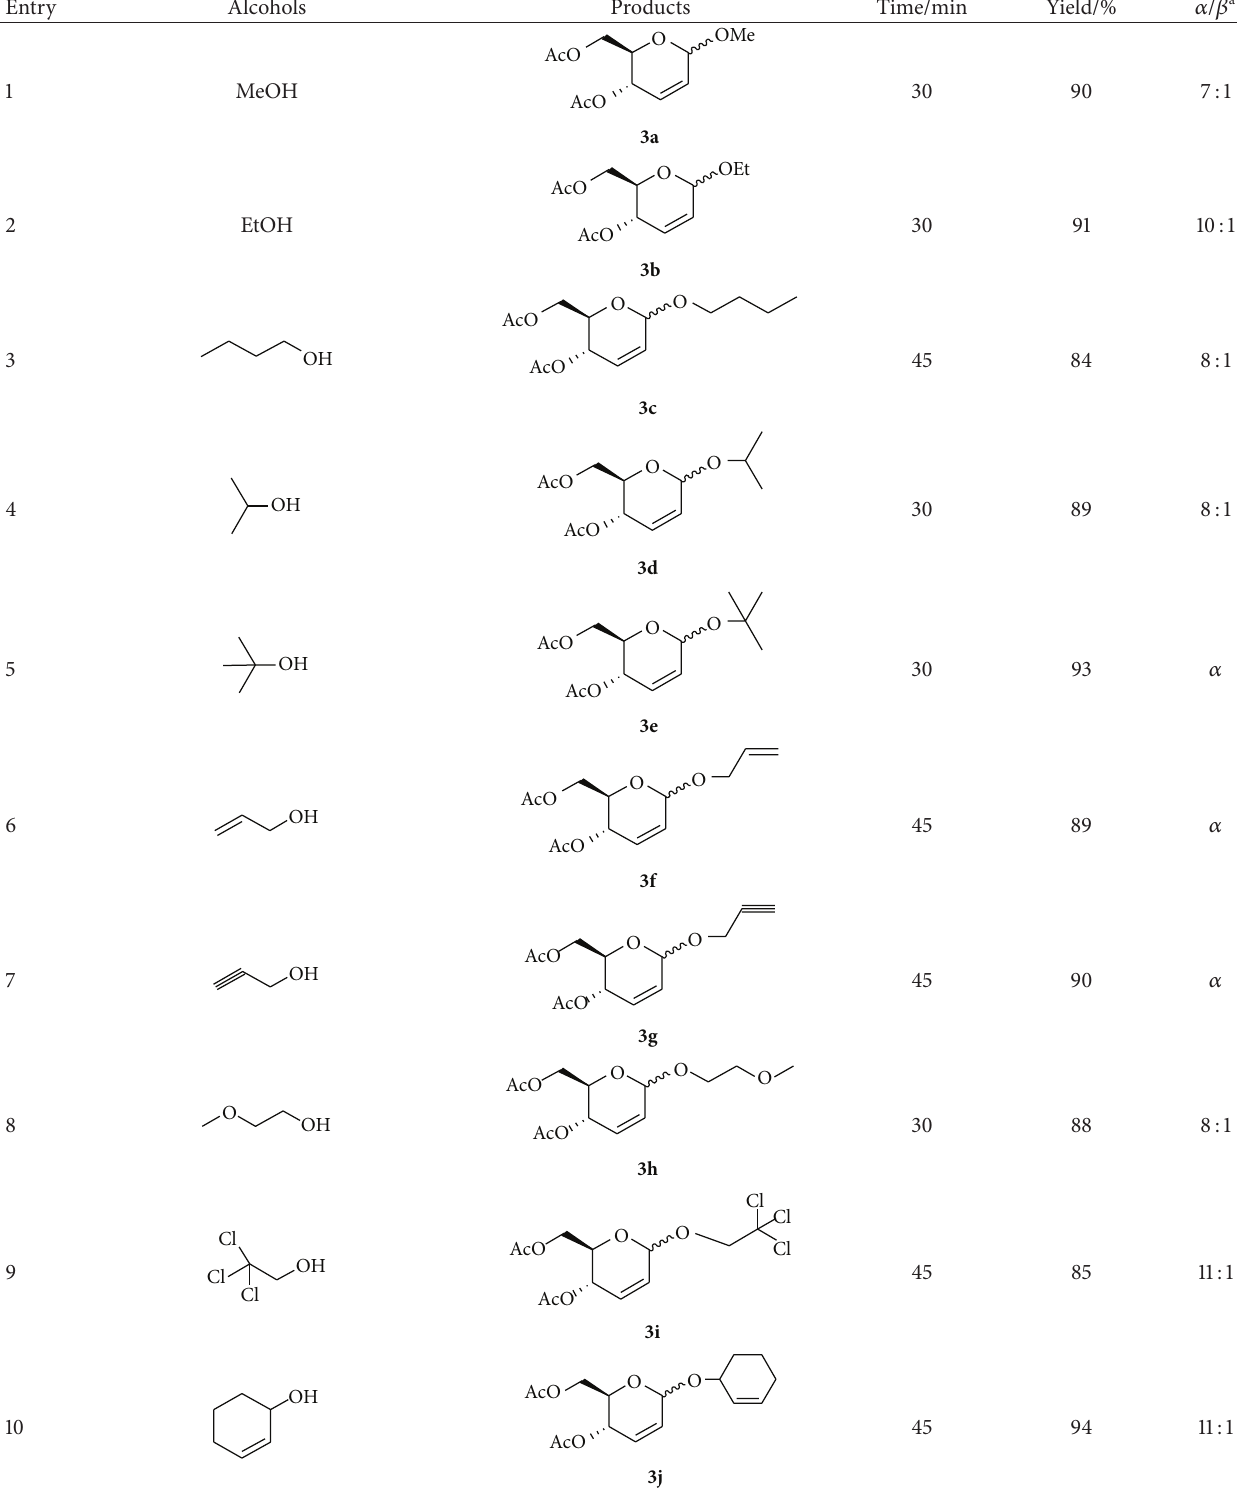
Table 2: Preparation of 2,3-unsaturated O